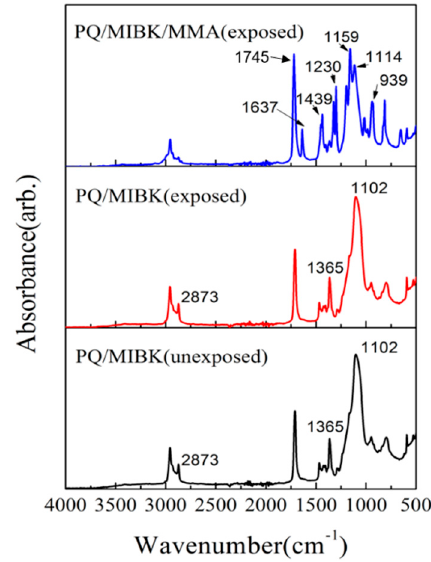
Figure 3. FT-IR absorption spectra of unexposed PQ/MIBK, exposed PQ/MIBK, and exposed PQ/MIBK/MMA.